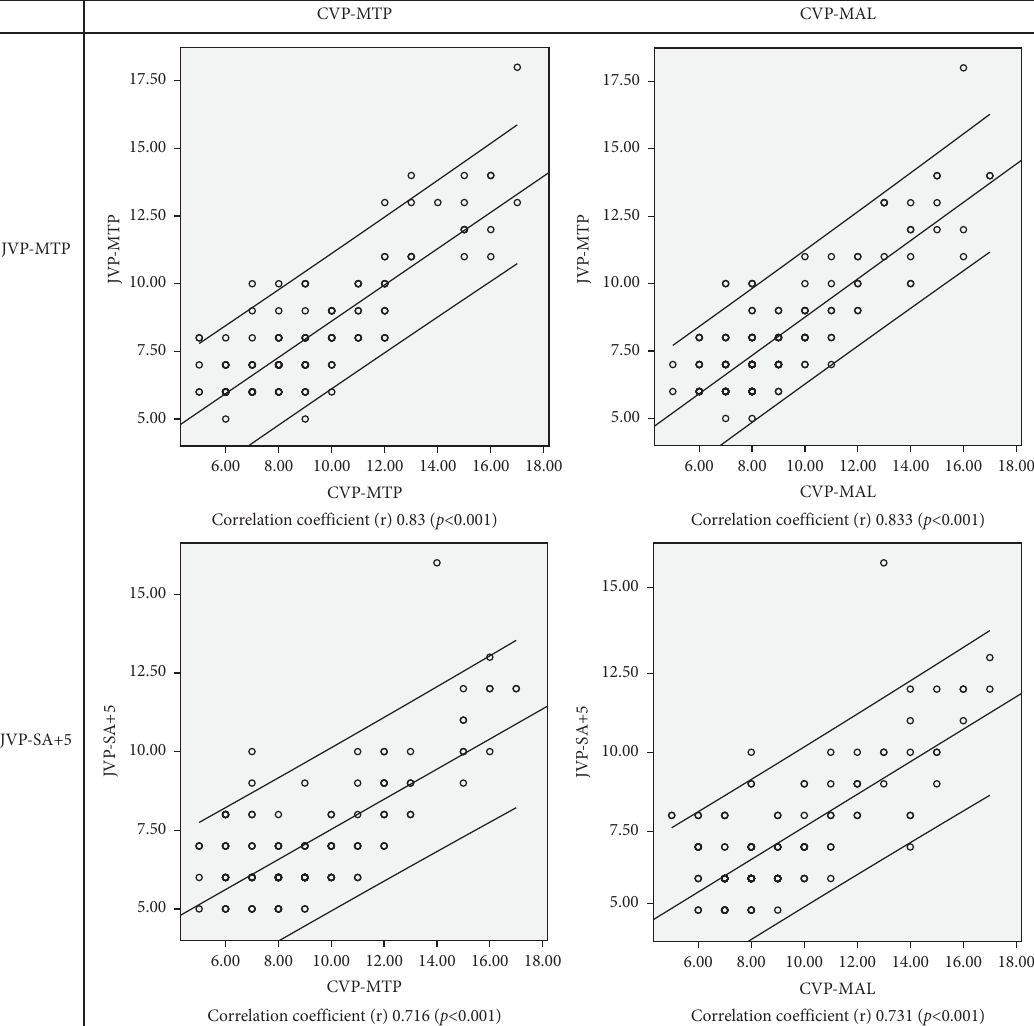
Figure 2: Pearson’s correlations of JVP-MTP and JVP-SA+5 with CVP-MTP and CVP-MAL of 150 subjects. CVP-MAL: central venous pressure (CVP) measured from the midaxillary line (MAL) at the fourth intercostal space; CVP-MTP: CVP measured from the midthoracic plane (MTP) at the anterior fourth intercostal space level; JVP-MTP: JVP measured from the MTP; JVP-SA+5: jugular venous pressure (JVP) measured from the sternal angle (SA) with the addition of